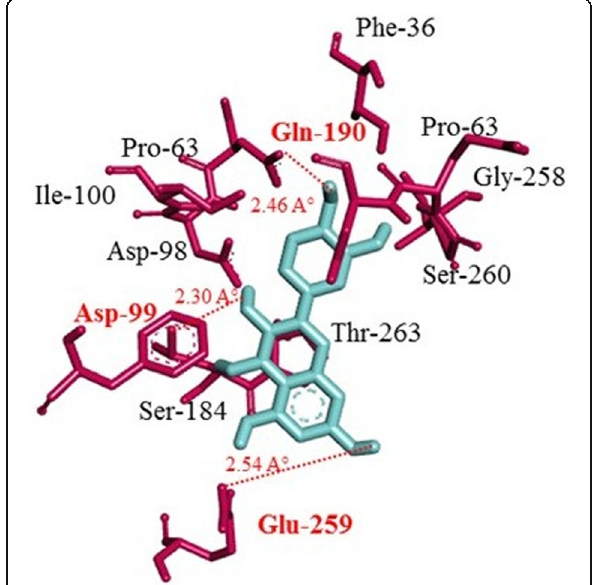
Fig. 7 Docking complexes of quercetin-Bcl2-associated X